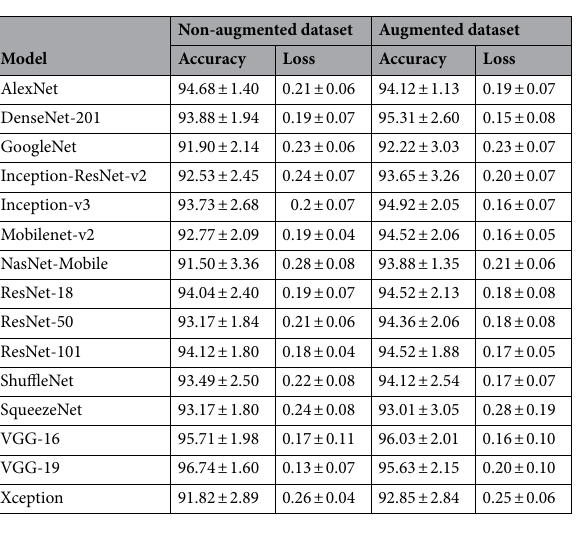
Table 2. The training final accuracy and loss values of the model using the non-augmented dataset and the models using the augmented dataset (accuracy: mean ± standard deviation %).